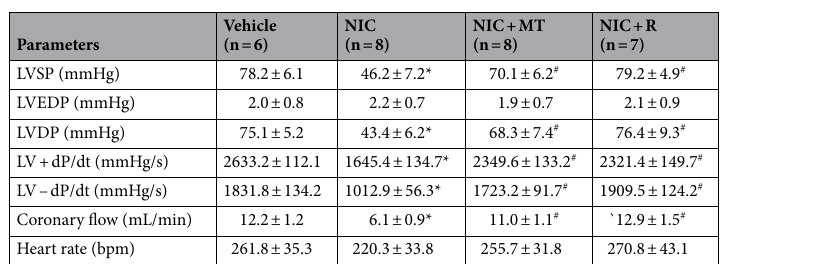
Table 2. End-point analysis of body weight, organ weight, and plasma cotinine in rats. All values are given as mean ± SEM for n = 6–8/group. LVDP left ventricular developed pressure, LVEDP left ventricular end-diastolic pressure, LV + dP/dt maximal rate of left ventricular contraction, LV – dP/dt maximal rate of left ventricular relaxation, LVSP left ventricular systolic pressure, NIC nicotine, NIC + MT nicotine + mitoTEMPO, NIC + R nicotine + resveratrol. * p < 0.05 versus vehicle group. # p < 0.05 versus NIC group using one-way ANOVA with Tukey post-hoc